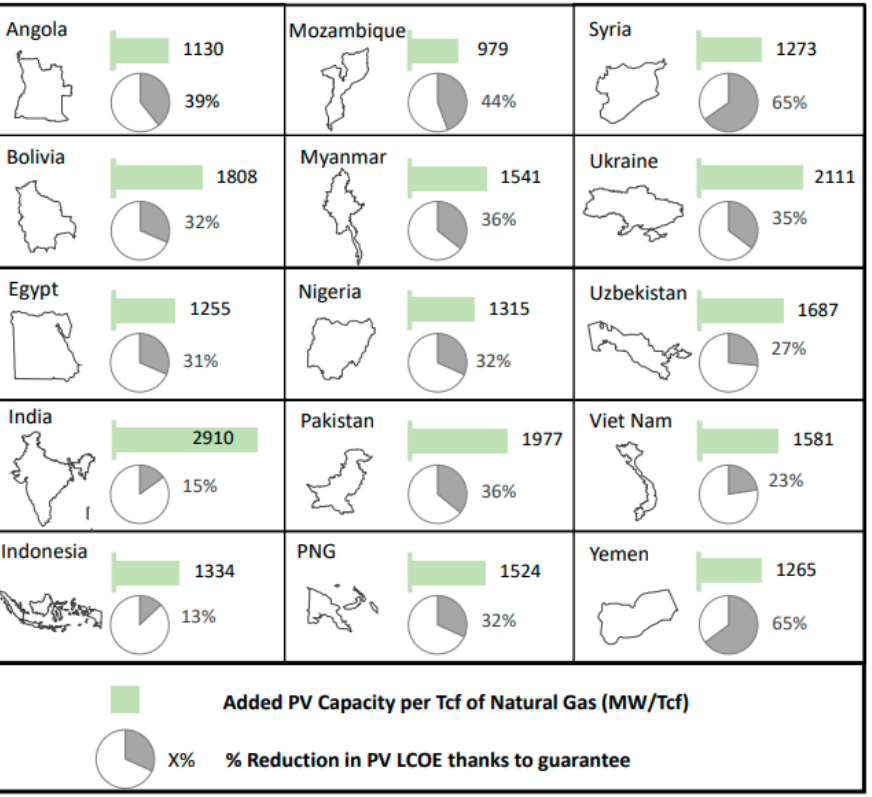
Figure 3. Added PV capacity per Tcf of natural gas and % reduction in PV LCOE across the 15 considered countries.